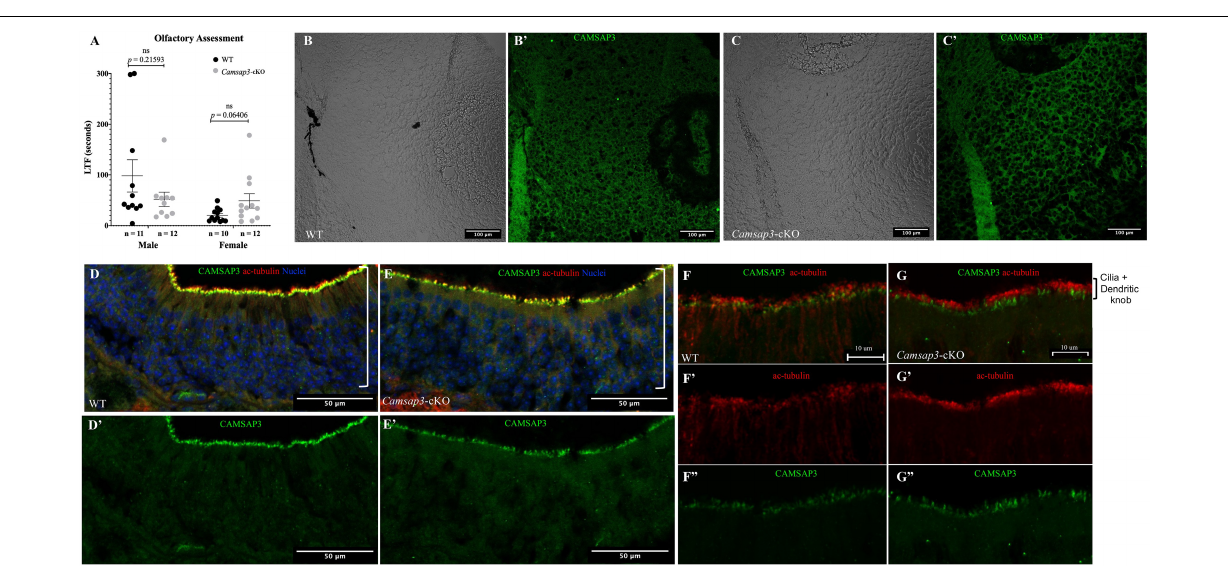
Frontiers in Cellular Neuroscience |